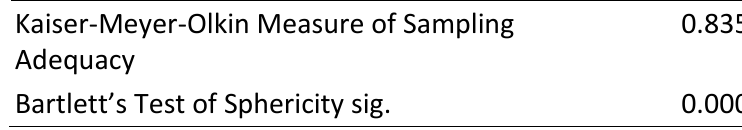
Table 1: Kaiser-Meyer-Olkin and Bartlett’s test results concerning the first stage of the